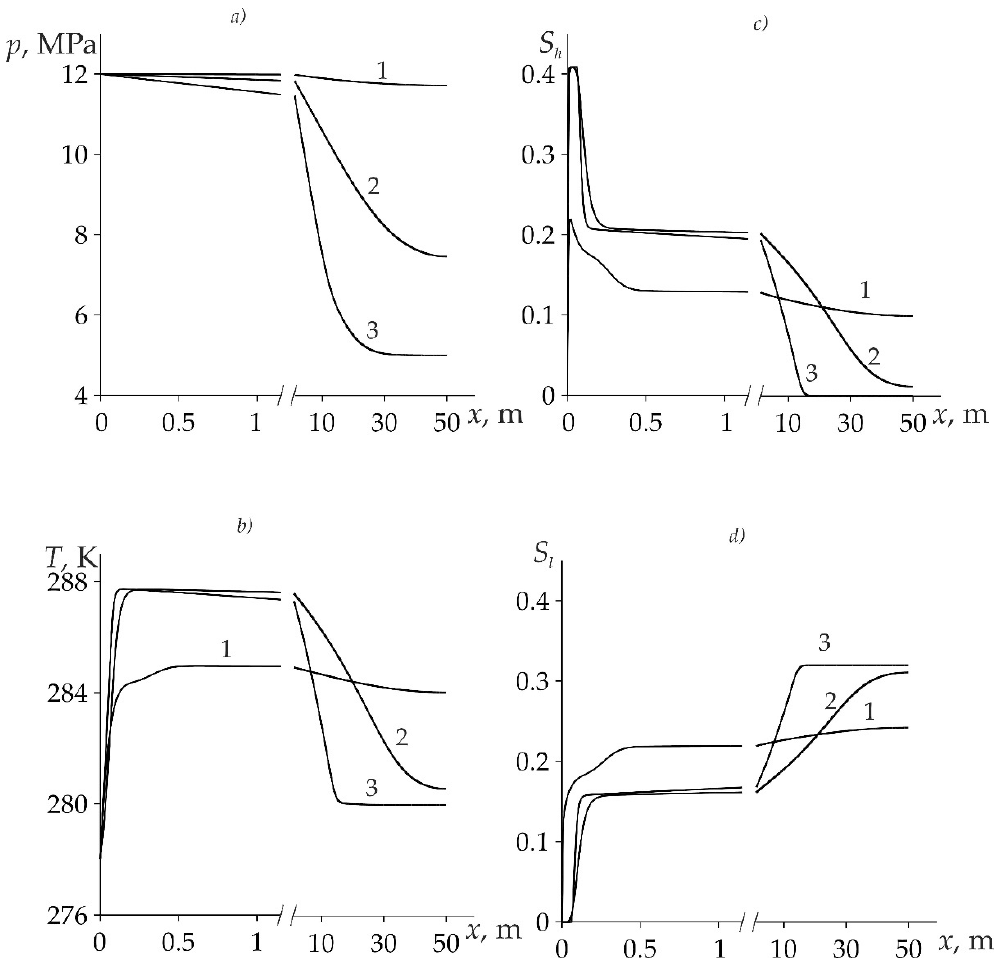
Figure 3. Distributions of pressure ( a ), temperature ( b ), hydrate saturation ( c ) and water saturation ( d ) at: k 0 = 10 − 12 m 2 (1), 10 − 13 m 2 (2), 10 − 14 m 2